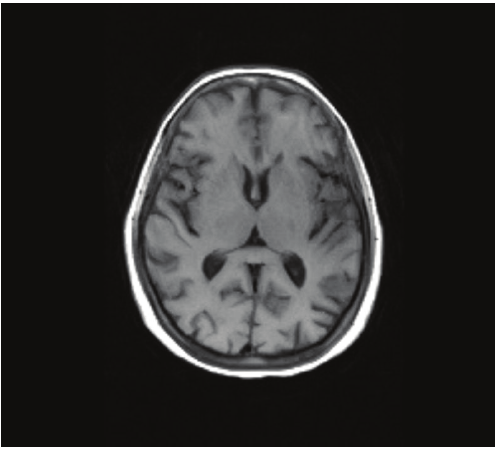
Figure 2: Coronal T2 image shows subcortical T2 hypointensity in right postcentral white matter.